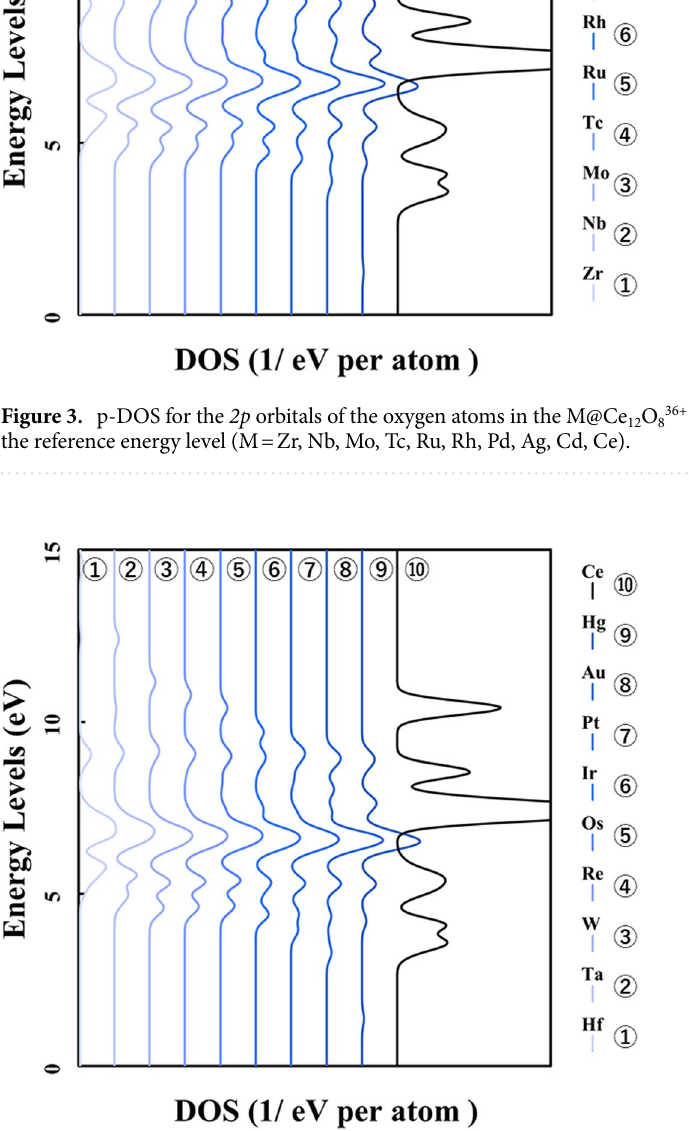
Figure 4. p-DOS for the 2p orbitals of the oxygen atoms in the M@Ce 12 O 836+ cluster model, the vacuum level is the reference energy level (M = Hf, Ta, W, Re, Os, Ir, Pt, Au, Hg,